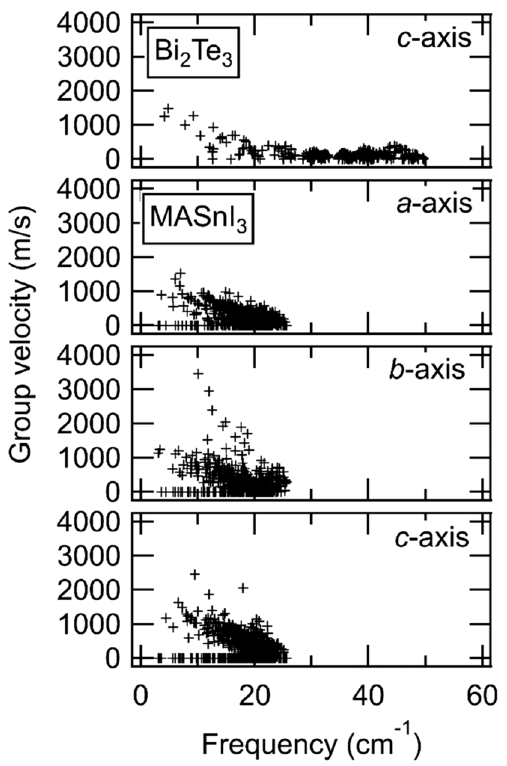
Figure 8. Group velocities of Bi 2 Te 3 along the c -axis and MASnI 3 along the a -axis, b -axis, and c